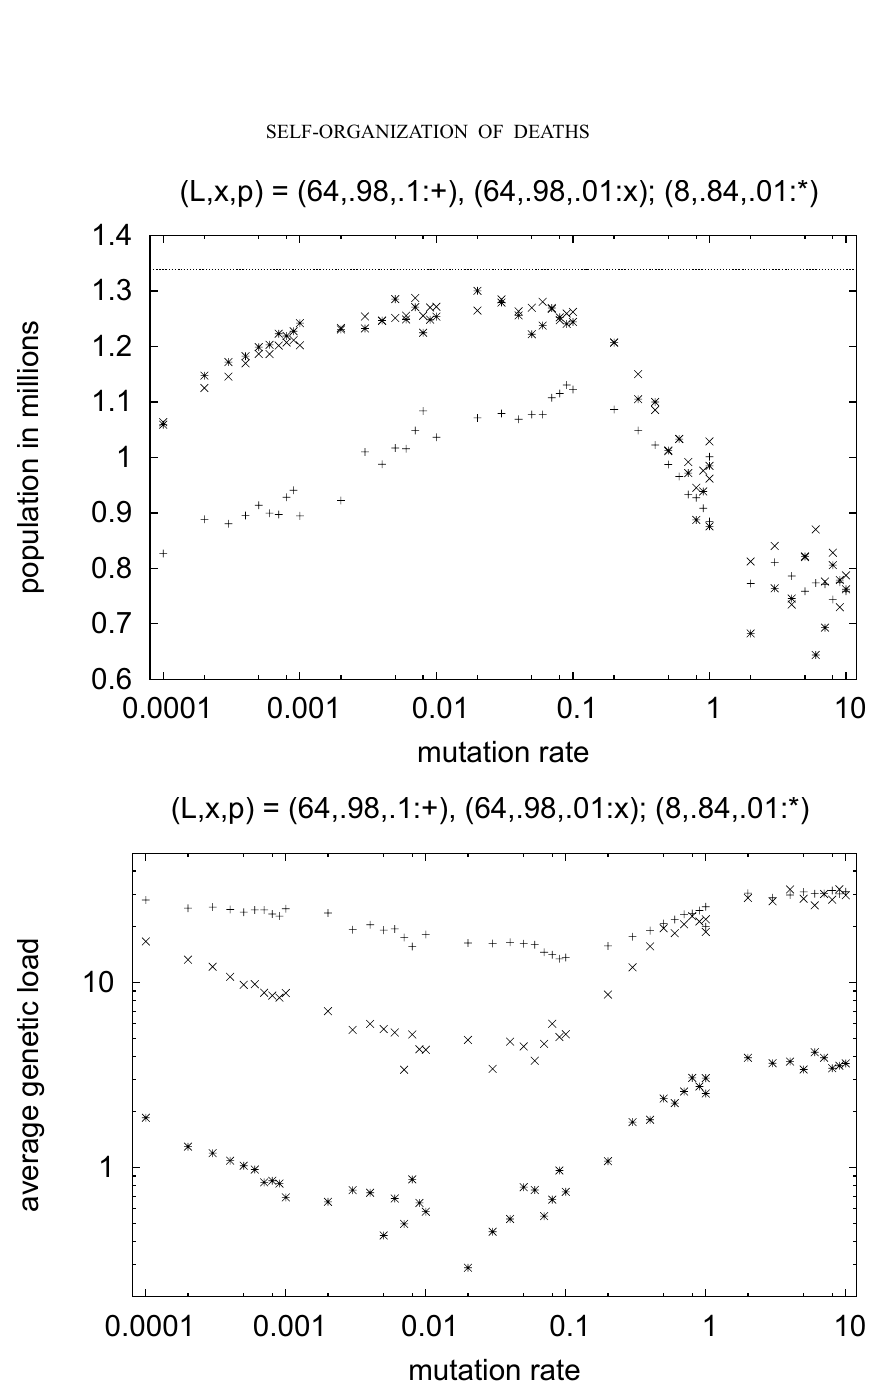
Fig. 1 – Model A1. Search for the optimal mutation rate, in which the population (top) reaches the maximal value and the number h N i of unadapted loci (genetic load, bottom) gets the minimal, at x = 0 . 98. For x = 0 . 99, L = 64, p = 0 . 01, the results are similar; for x = 0 . 96, the populations die out for some values of these